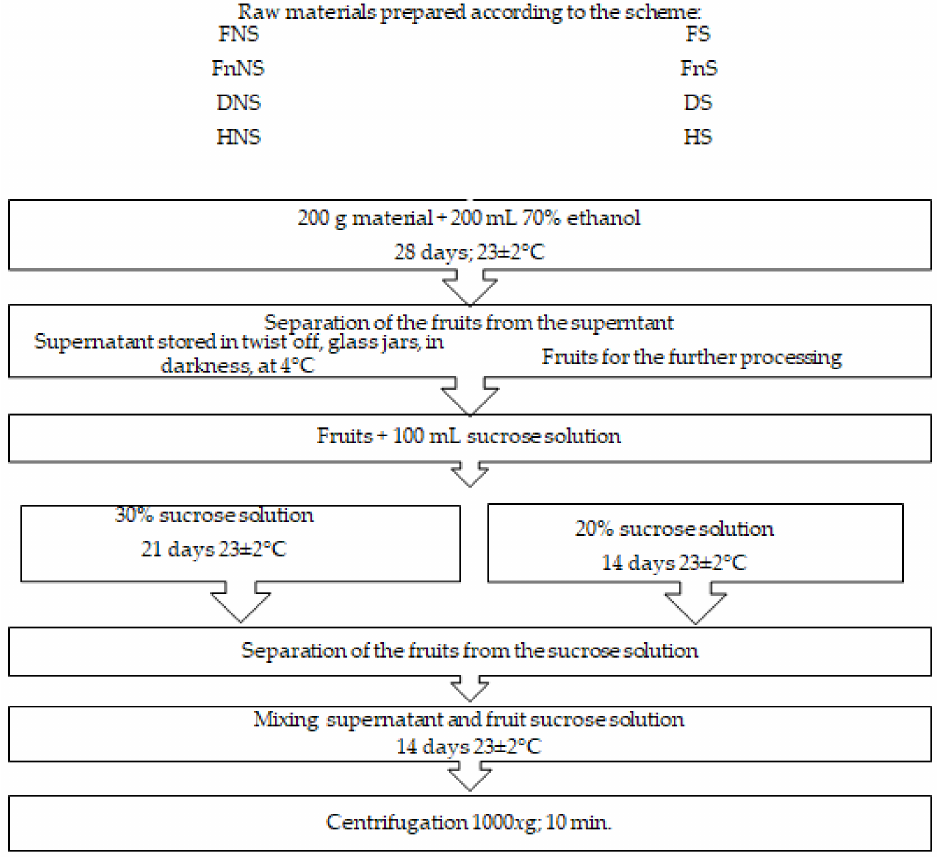
Figure 3. Scheme of liqueur production from pre-treated accessory hawthorn